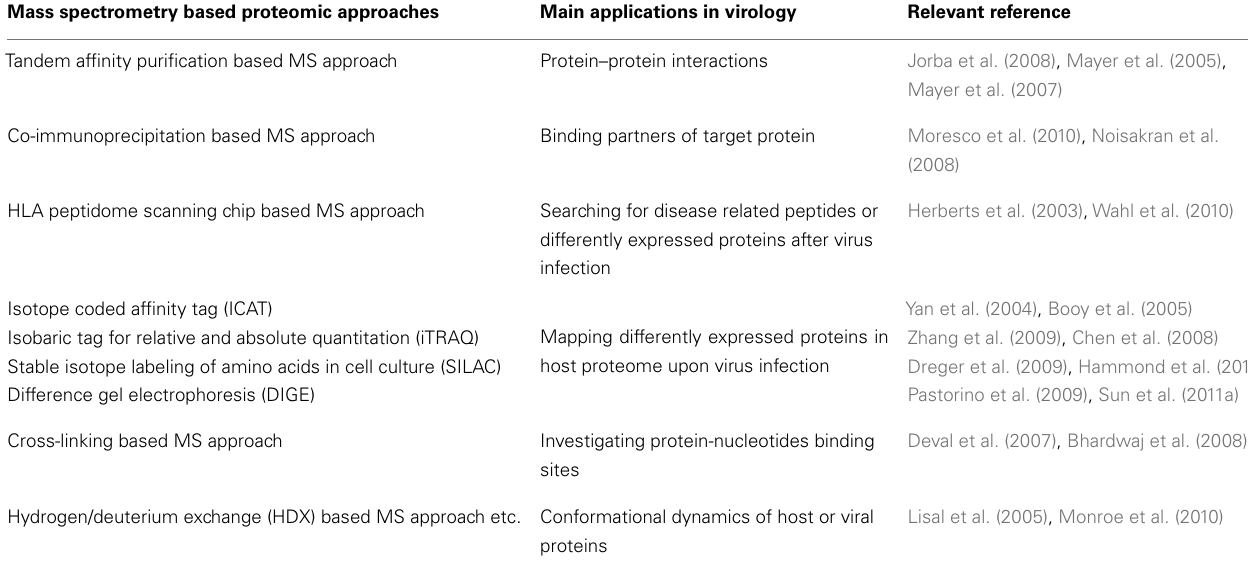
Table 1 |A summary of proteomic techniques and their applications in